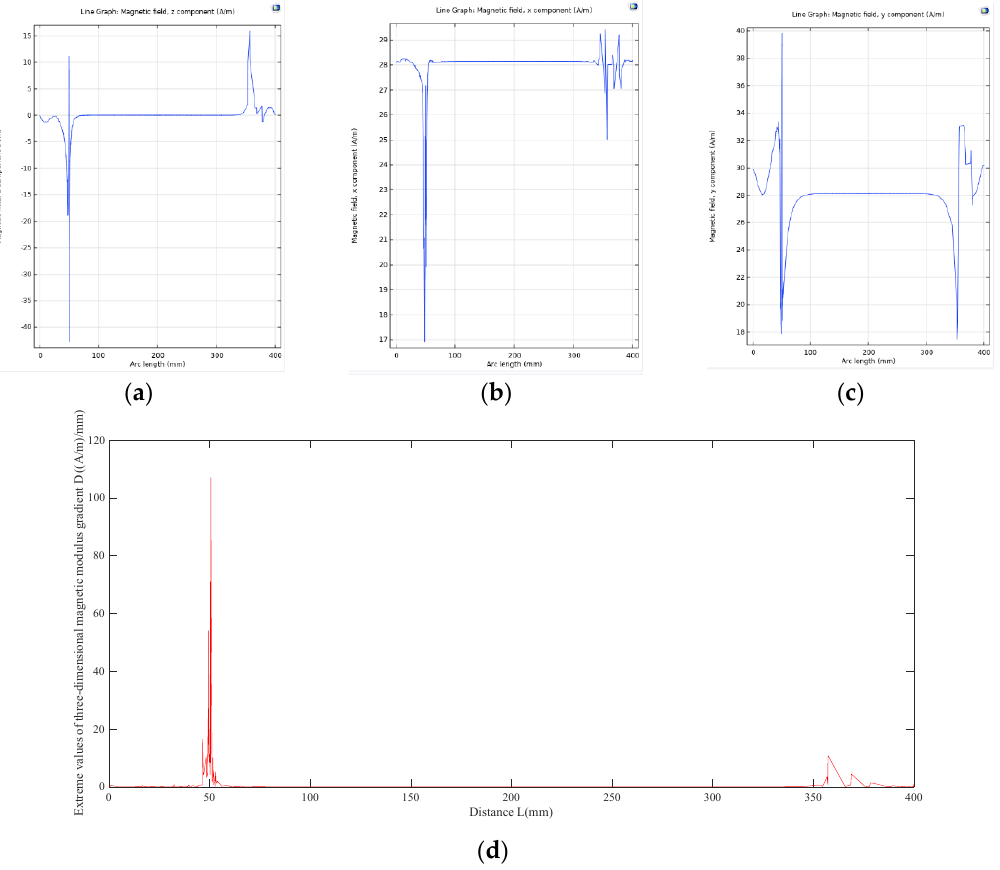
Figure 8. Defect at 50 mm after 1400 s of heat dissipation. ( a ) Normal component Z; ( b ) Tangential component X; ( c ) Tangential component Y; ( d ) Three-dimensional magnetic modulus gradient.